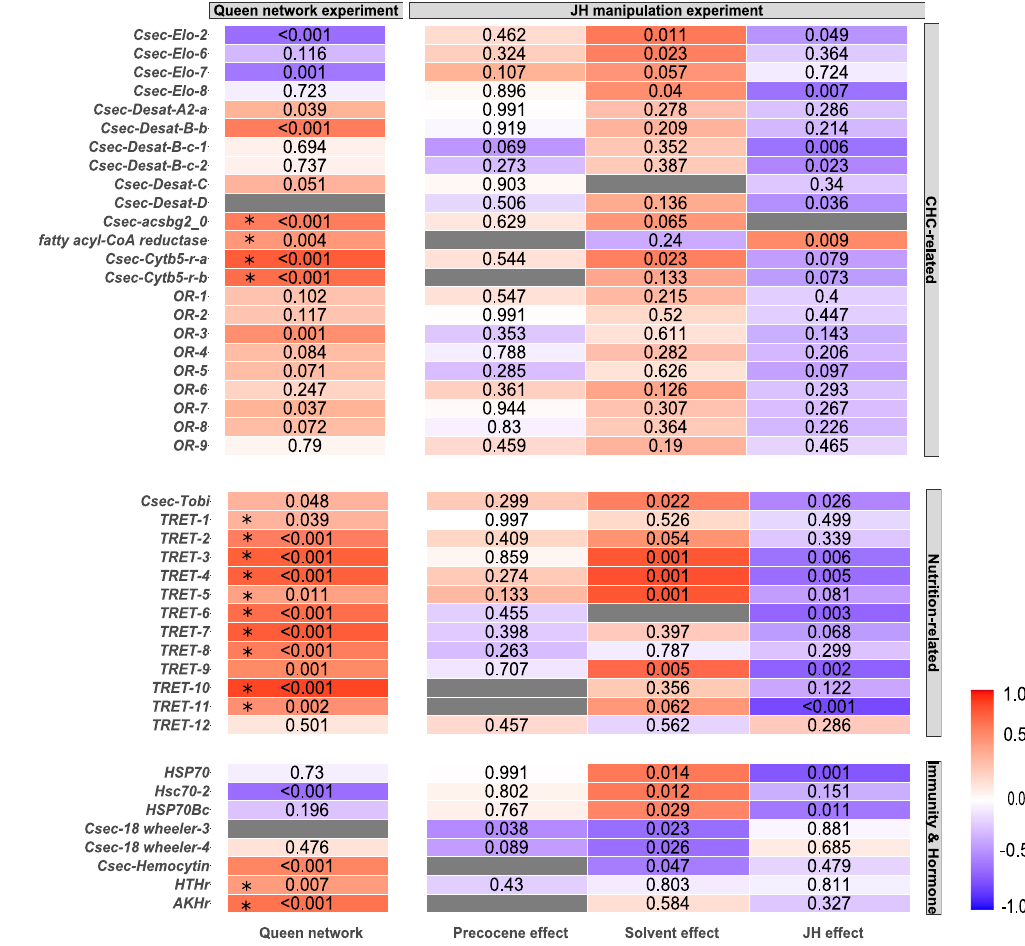
Fig. 4 Heatmap for the WGCNA results related with CHCs, nutrition, immunity and hormones. Shown are the results of the co-expression analyses for the queen network experiment (column 1: queen network from queen – worker comparisons; n worker = 14; n queen = 14) and the JH-manipulation experiment with comparisons between precocene – control (column 2: precocene effect), the solvent – control (column 3: solvent effect), and the precocene – solvent (column 4: JH effect) ( n precocene = 12, n solvent = 7, n control = 6). Genes that are related to cuticular hydrocarbons (CHC) biosynthesis, nutrition, immunity, and hormonal regulation are given. For more information, see Fig.